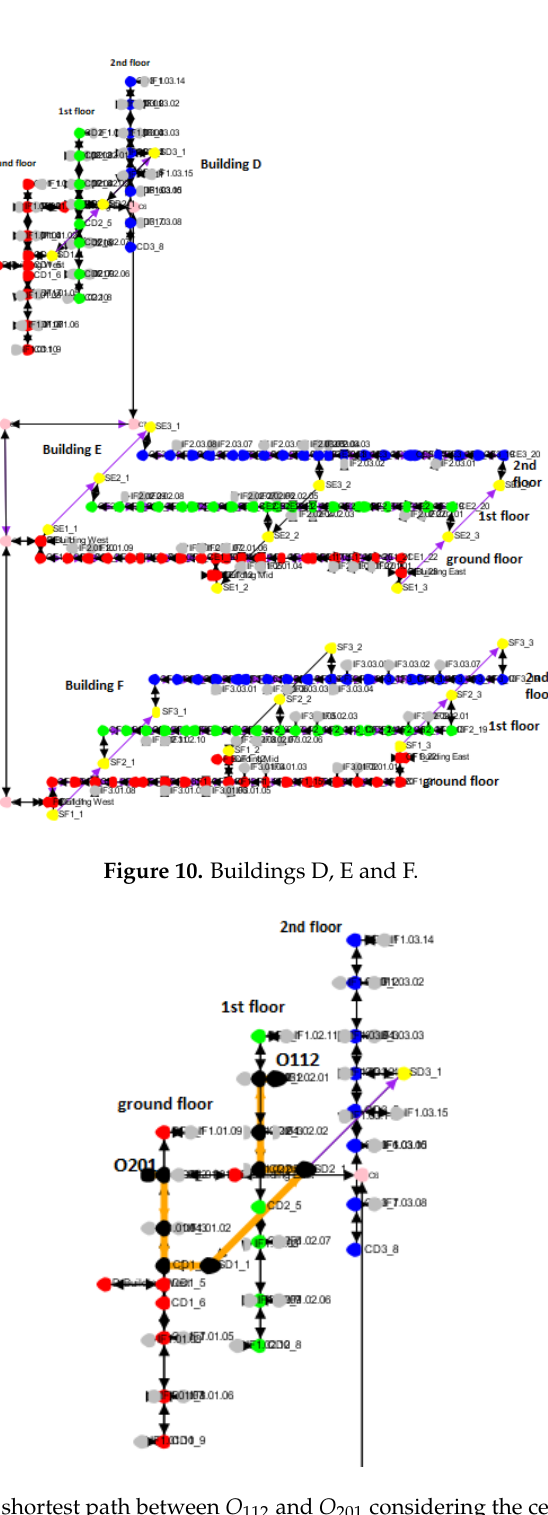
Figure 11. The shortest path between O 112 and O 201 considering the cells